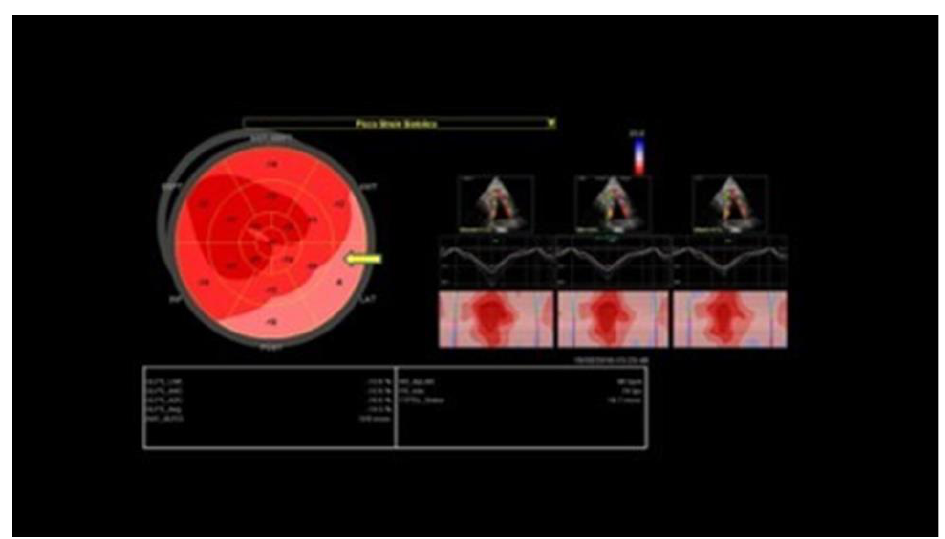
Figure 3. Bull’s eye representing a two-dimensional longitudinal strain of the same patient in Figure 1, with impairment of myocardial deformation in postero-lateral walls.